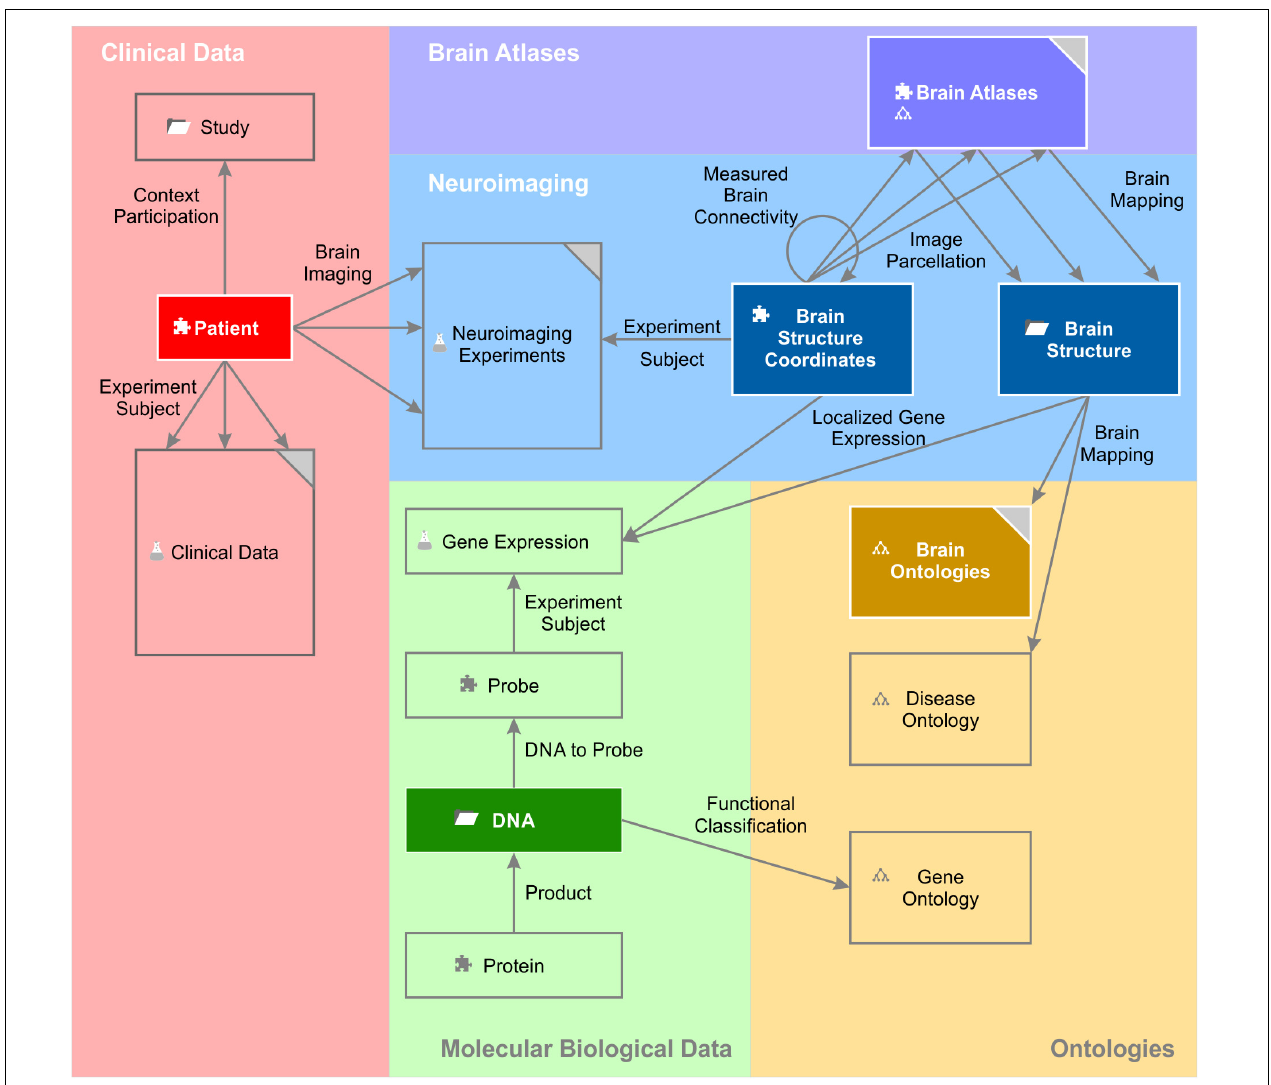
FIGURE 1 | A simplified brain-data knowledge model. The knowledge model can be subdivided in at least five sub-domains: clinical, neuroimaging, molecular biological data, brain atlas, and brain ontology. Rectangles indicate semantic object types or groups of corresponding semantic object types indicated by the gray triangle in the top right corner. Darker background colors of rectangles indicate key objects of the subdomains. Semantic object types are derived from a static set of object kinds indicated by a small icon preceding the object name. The puzzle tile icon indicates the most basic object kind the “element.” The folder icon indicates the object kind “context,” the glass flask icon the object kind “experiment” and the tree diagram icon the object kind “ontology.” The different “brain atlases” can be derived either from kind element or ontology. The arrows indicate the semantic relations between the different objects or even between the same object types (e.g., “measured brain connectivity”). Classes of semantic relations can connect different multiple source and target objects with each other. For example, the relation class “brain imaging” relates the patient with data from the different imaging modalities. “Experiment subject” is a special relation belonging to the semantic object kind experiment. Every experiment has got exactly one semantic object type as its subject. It identifies the individual data entries of this experiment (cf. main